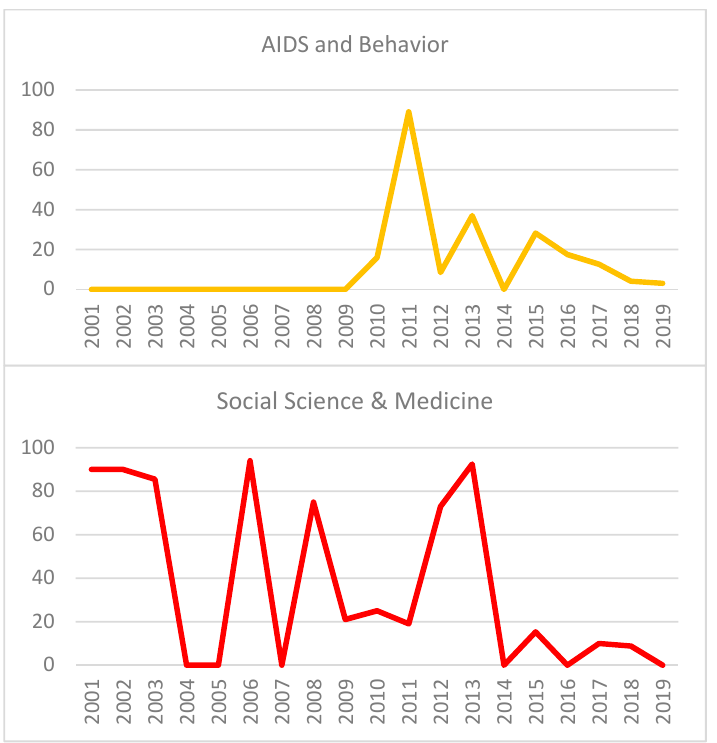
Figure 3. Citations per article of journals in the 21st century.